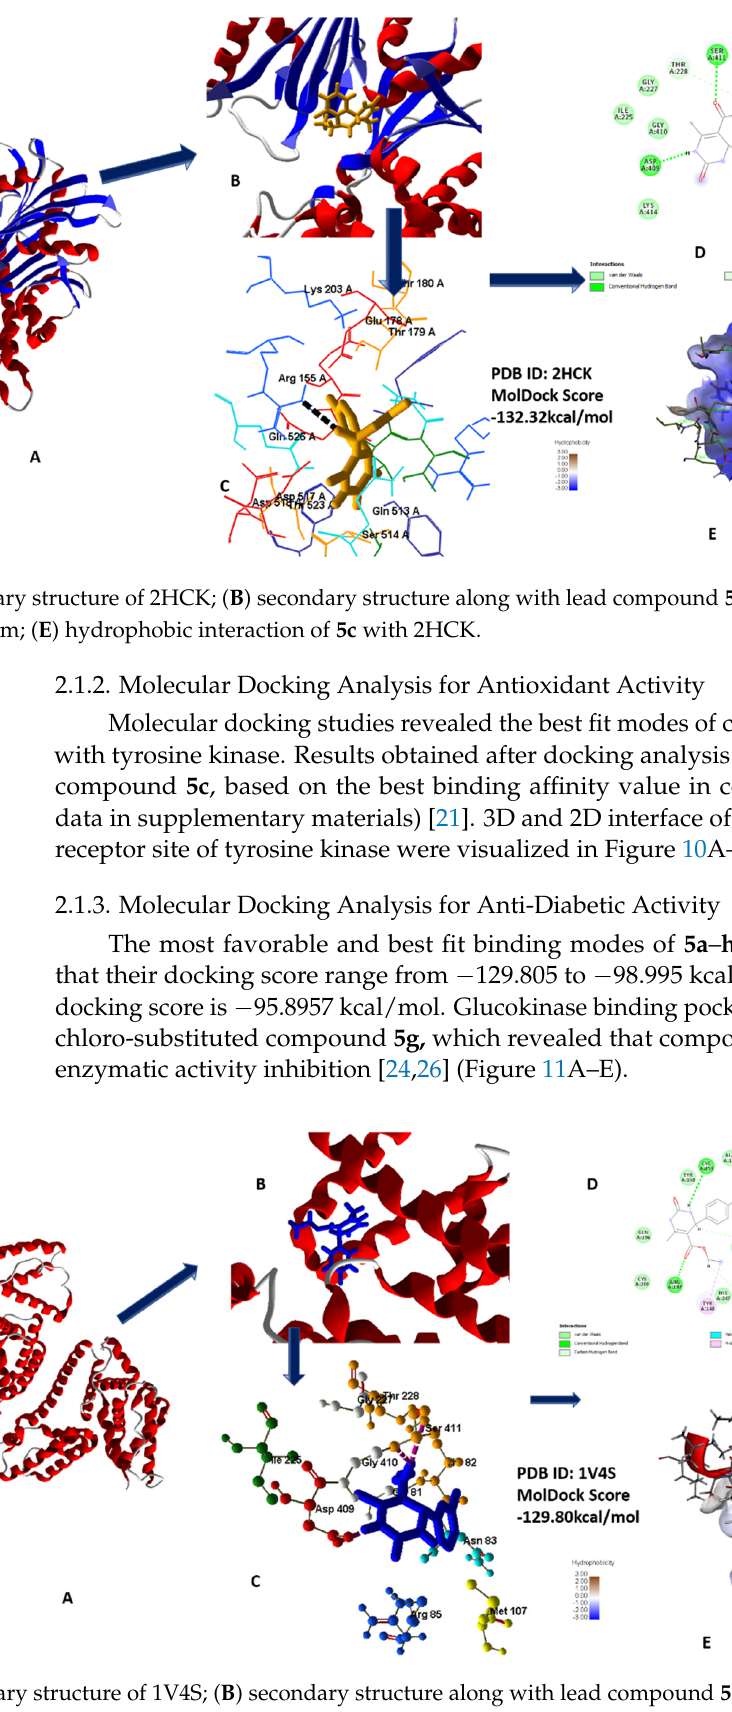
Figure 11. ( A ) Secondary structure of 1V4S; ( B ) secondary structure along with lead compound 5g ; ( C ) 3D interaction with protein; ( D ) 2D diagram; ( E ) hydrophobic interaction of 5g with 1V4S.